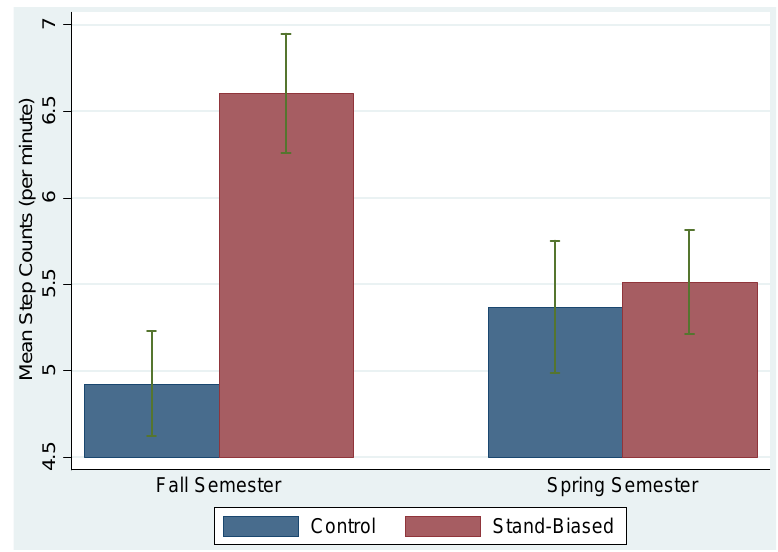
Figure 3. Plots of mean step counts and their 95% confidence intervals for treatment (stand-biased) and control groups in the fall and spring